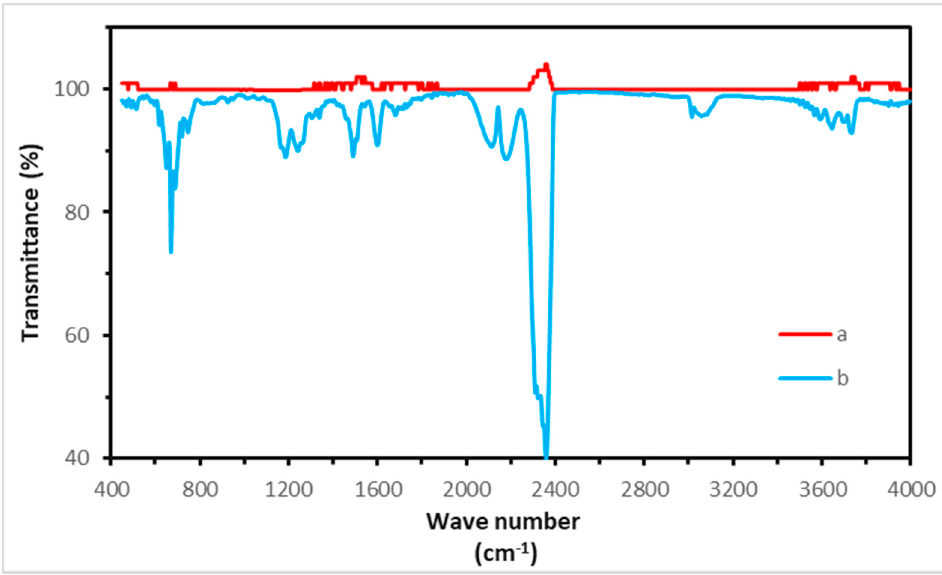
Figure 18. Fourier Transform Infrared spectra of PEEK: ( a ) before start of degradation, and ( b ) at maximum rate of weight loss.